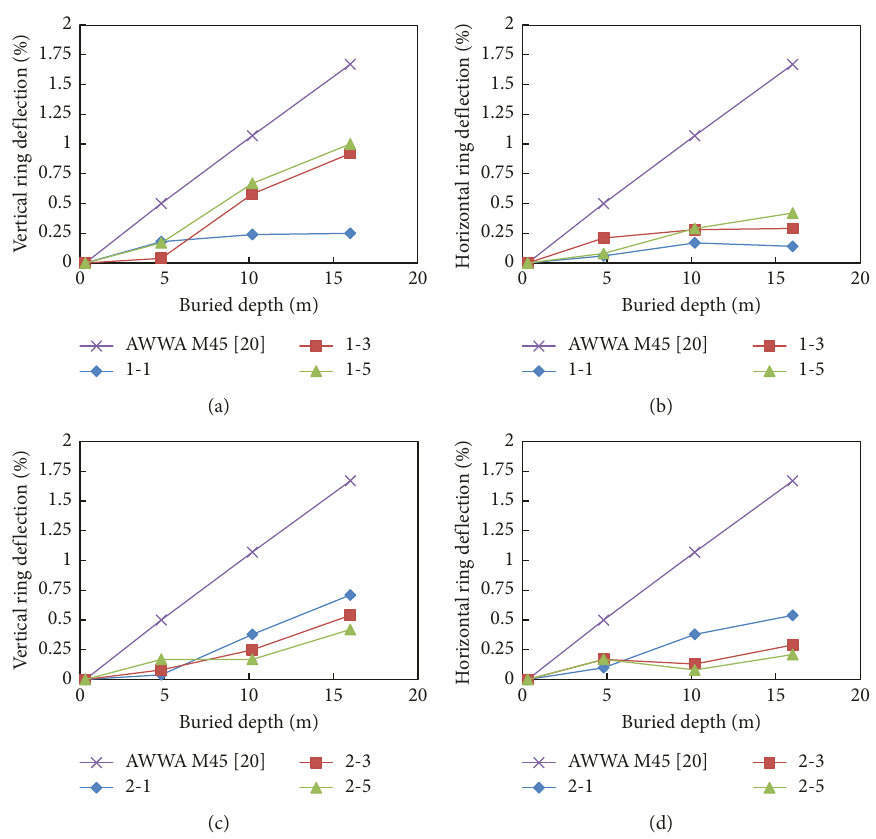
Figure 7: Comparison of ring deflection of the GFRP pipe with respect to buried